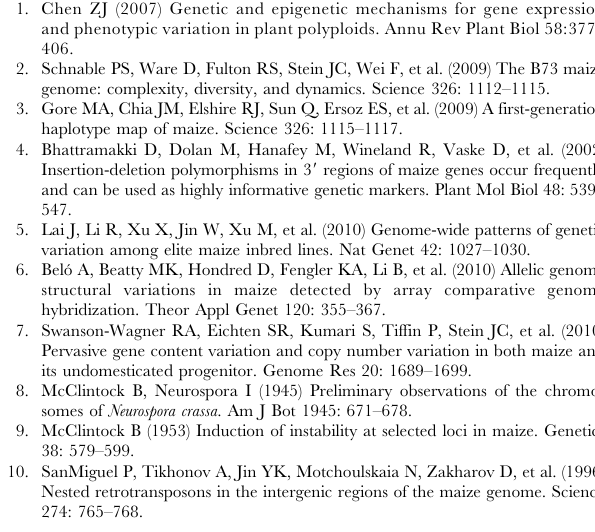
Table S10 Expression correlation between genes with unex- pected patterns and their homologous genes. a shows the middle physical position (equals the sum of the position of the transcriptional start site and the terminal site divided by 2) of the gene; b is the genetic position in the IBM population; c indicates the coefficient of correlation; d is the action type, cis indicates the two duplicate genes are located in the same genomic region, while trans shows the two duplicate genes are not in the same genomic region. In the column of ‘‘Syntenic Classification’’, S, I, and U represent Syntenic, Inserted and Unknown, respectively. Table S11 Co-regulated genes at hotspots and genes with cis- eQTL near trans-eQTL hotspots. a refers to trans-eQTL hotspts. b is the gene with cis- eQTL underneath the hotspot; c indicates the number of regulated genes by hotspot; d is the number of shared genes co-expressed with a cis- regulated gene and also found within a hotspot. Table S12 Primer information used for validation. The ‘‘partial’’ in Validation Status column means the expression in a few RILs (less than 2 RILs out of 10 tested RILs) of the other independent replication did not match with RNA-seq but the gene still showed an unexpected expression